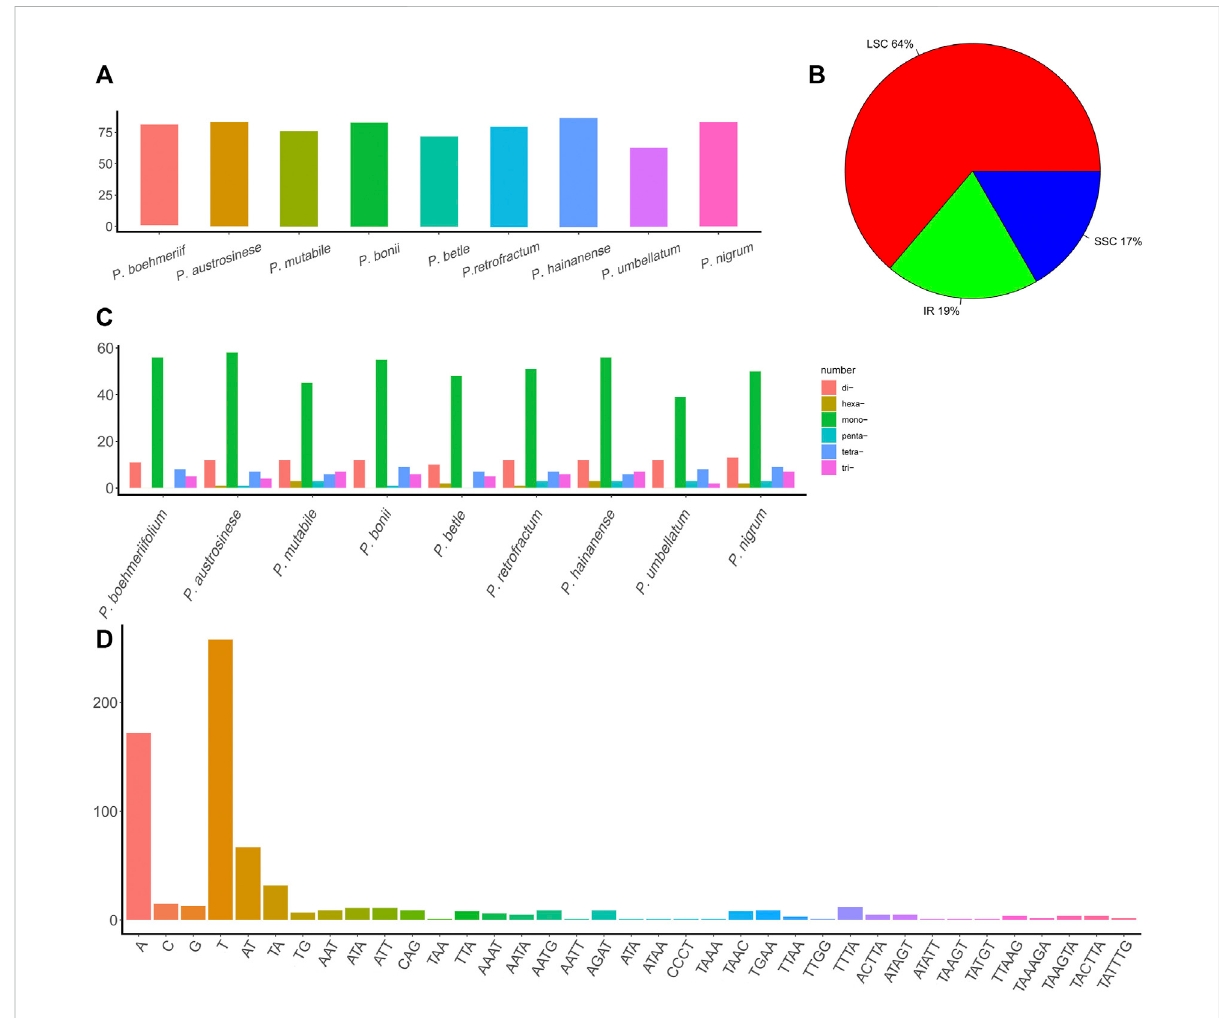
FIGURE 3 The SSRs in Piper chloroplast genomes. (A) The number of SSRs in different Piper species. (B) The proportion of SSRs in the three regions (IR, LSC, and SSC). (C) The number of different types of SSRs (mononucleotides, dinucleotides, trinucleotides, tetranucleotides, pentanucleotides, and hexanucleotides). (D) The number of each